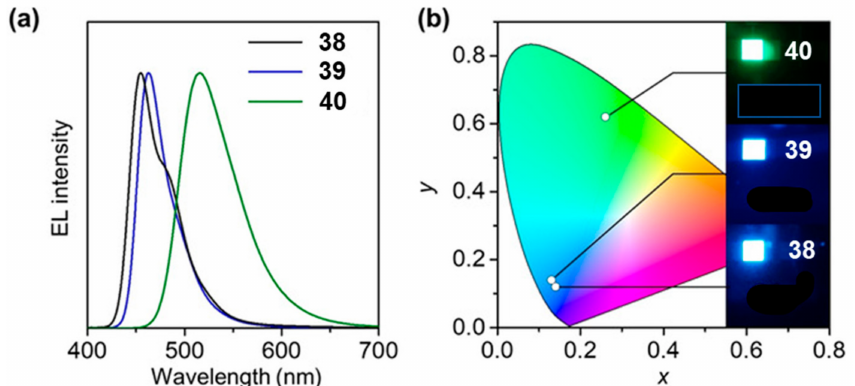
Figure 3. EL characteristics of OLEDs based on 38 , 39 and 40 as MR-TADF emitters: ( a ) EL spectra measured at 1 mA cm − 2 , ( b ) EL emission images and their color coordinates in the Commission Internationale de l’Eclairage (CIE) chromaticity diagram (Reproduced with permission from H. Min et al., Angewandte Chemie International Edition; published by German Chemical Society (GDCh),